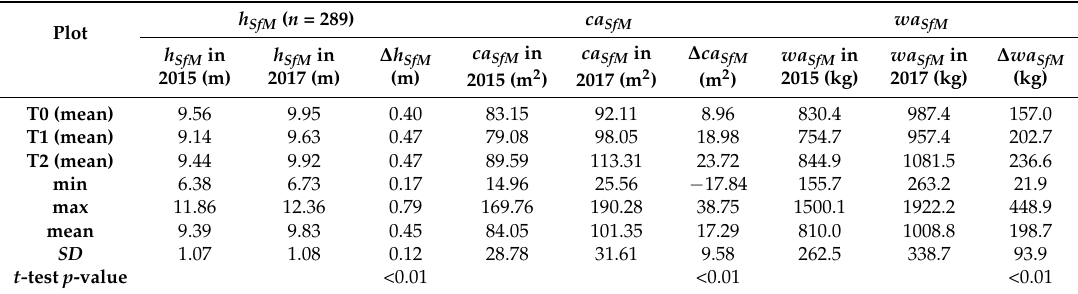
Table 5. Estimated image-based growth associated with each treatment for the entire dataset ( N = 96 (T0); N = 94 (T1), N = 100 (T2)).